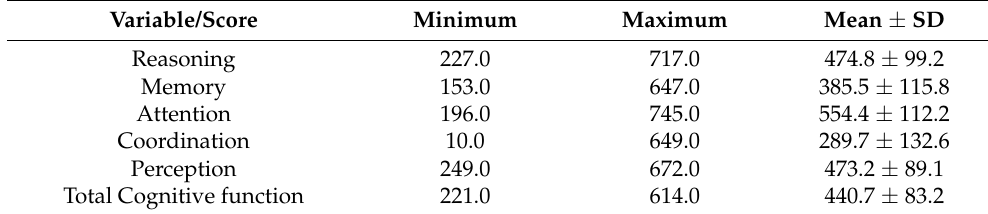
Table 3. Results of the cognitive test (mean and SD).